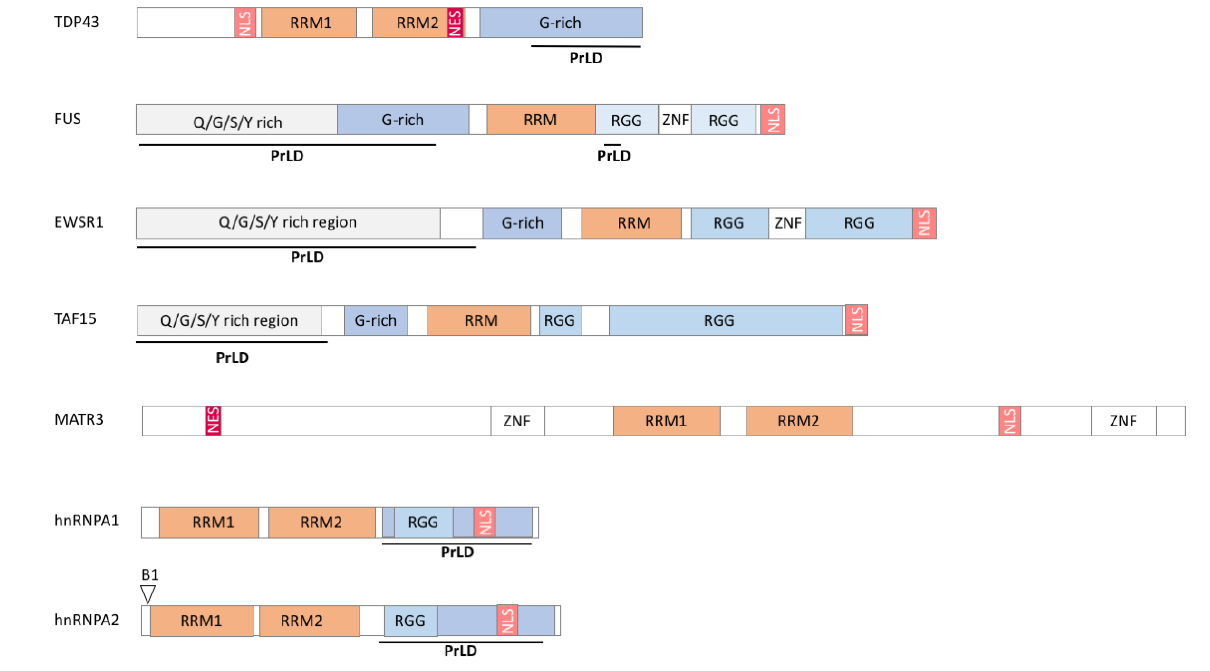
FIGURE 1: Domain organization of RBPs with prion like domains. NLS: nuclear localization signal, NES: nuclear export signal, RRM: RNA recognition motif, RGG:arginine/glycine-rich region, G-rich: glycine-rich region, ZNF: Zinc finger motif, Q/G/S/Y rich region: glutamine, gly- cine, serine and tyrosine-rich region, B1: B1 isoform of hnRNPA2, PrLD : prion like